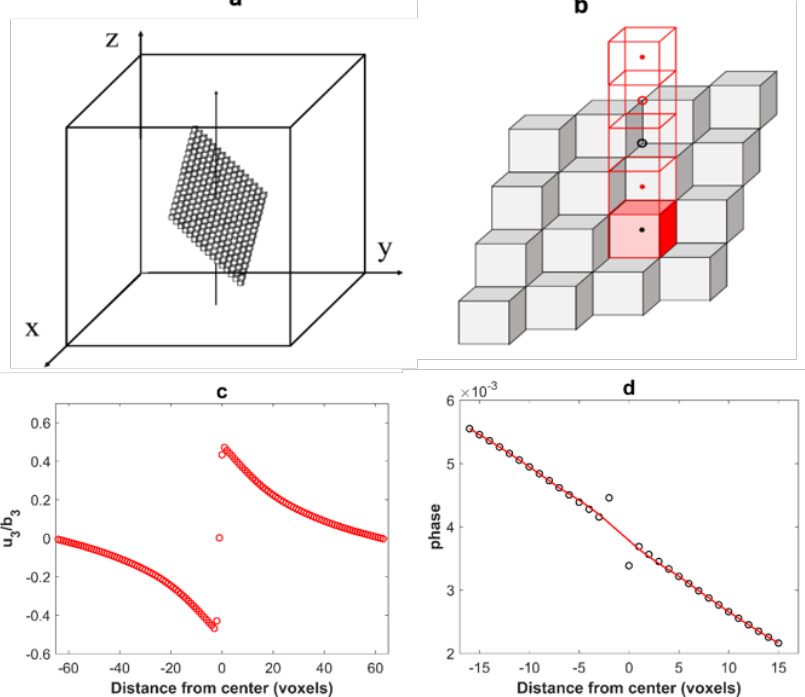
Figure 2. ( a ) Modeling of a dislocation loop in a (111) plane as a layer of voxels with eigenstrain; ( b ) position of the computed points relative to the transformed voxels with eigenstrains; ( c ) plot of the displacement field u 3 (normalized by b 3 ) along the z direction for the dislocation loop of Figure 2; ( d ) local oscillation of the phase due to the voxelization of the dislocation loop (the representation is made for 32 voxels centered in the unit cell along z direction). The red line is approximately equal to the phase expected for this displacement field.